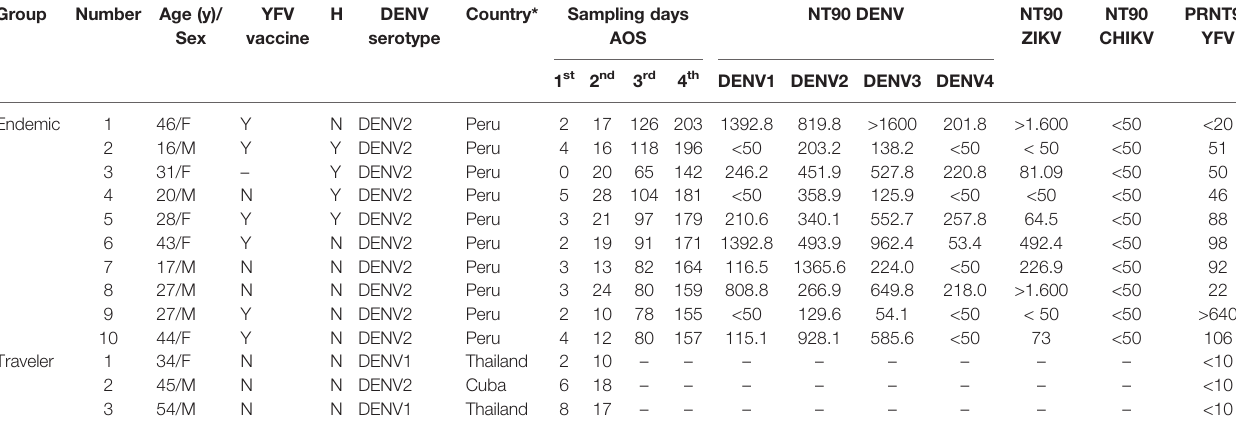
TABLE 1 | Samples included in the